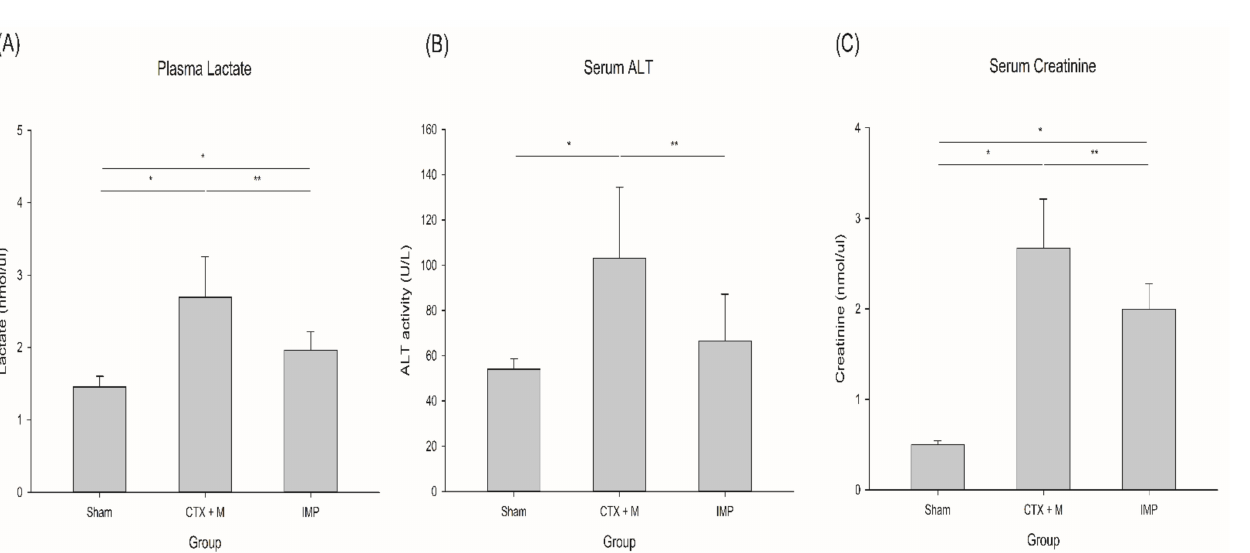
Figure 3. Effects of different antibiotic treatments on organ injury in severe IAI model. ( A ) Plasma lactate, ( B ) serum ALT, ( C ) serum creatinine. n = 3 for sham, n = 14 for IMP and CTX + M, * p < 0.05 compared with sham, ** p compared with CTX + M model. IAI, intraabdominal infection; CTX + M, ceftriaxone with metronidazole; IMP, imipenem; ALT, alanine